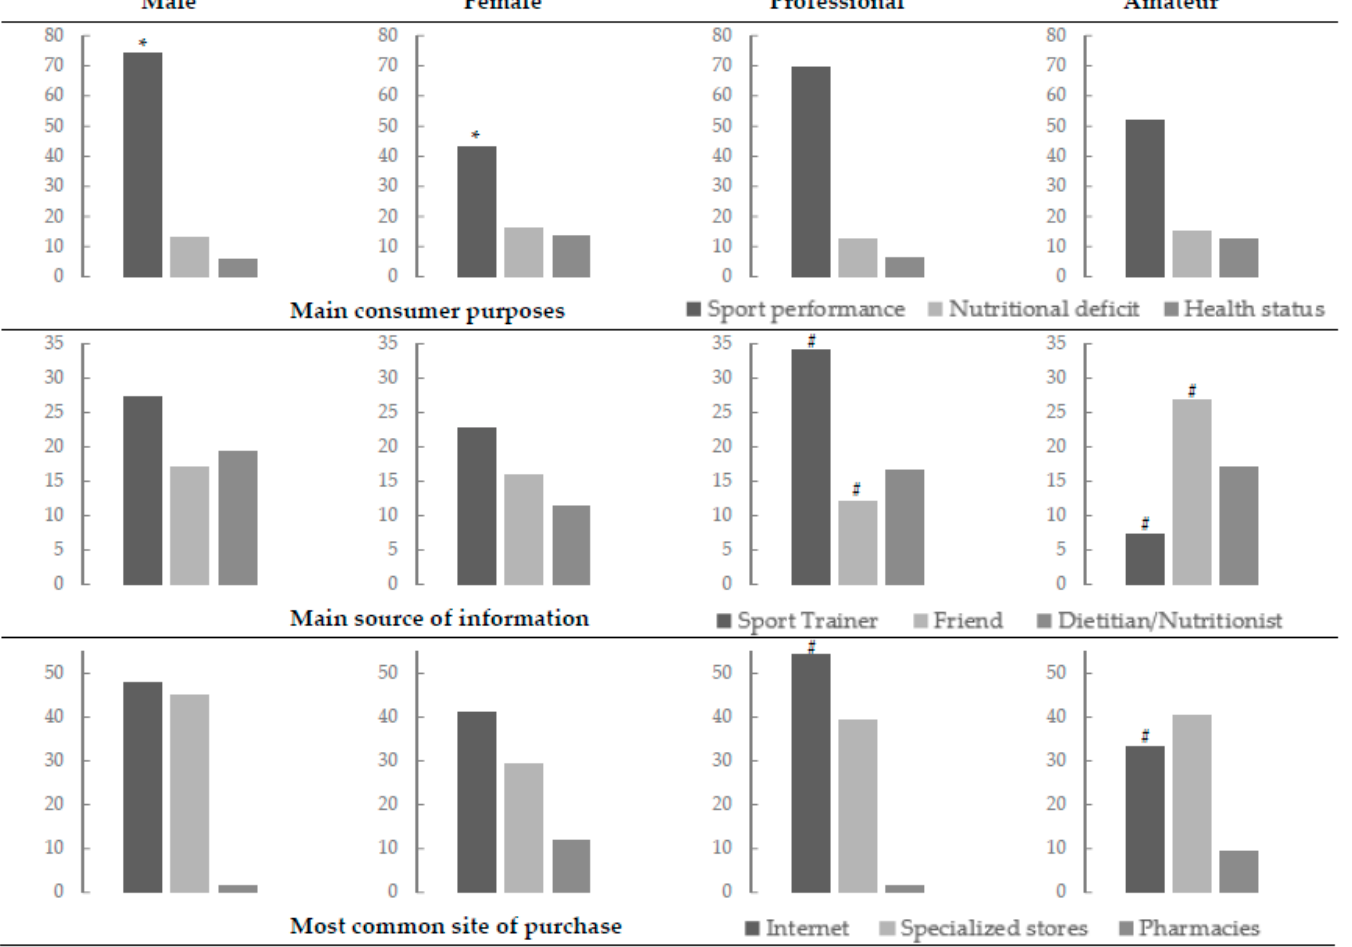
Figure 1. Main consumer purpose, source of information and site of purchase (sex and level of performance) (expressed as a percentage). * Relative risk of dietary supplement DS consumption of male vs. female players; # Relative risk of DS consumption of professional vs. amateur players.